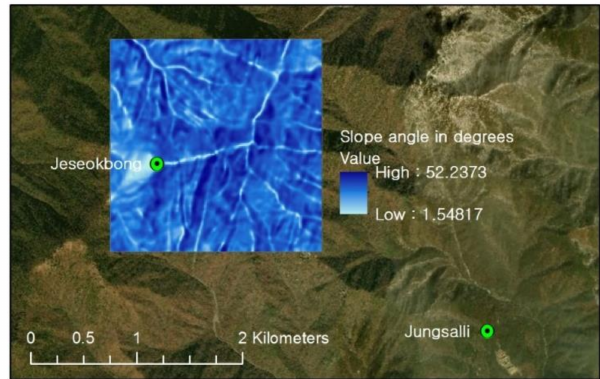
Figure 11. Slope angles of the analysis domain